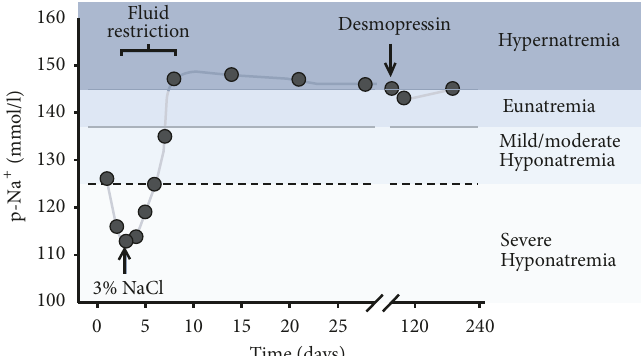
Figure 1: Plasma concentrations of sodium. Horizontal axis depicts time course from hospital admission (day 0) until 180 days’ follow-up. Verticalaxis depicts plasma sodium concentrations (p-Na + ). Hyponatremia was treated with intravenous hyperosmolar sodium infusion (3% NaCl at day 2) and fluid restriction (day 2 to day 5). The subsequent development of central diabetes insipidus (CDI) was treated with low dose desmopressin (initiated around day 60).